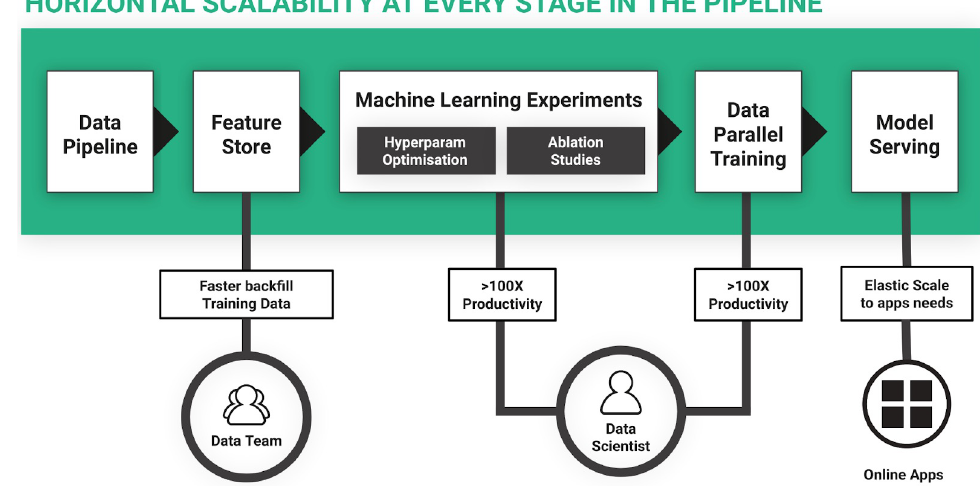
Figure 1. Horizontally scalable end-to-end ML/DL pipeline